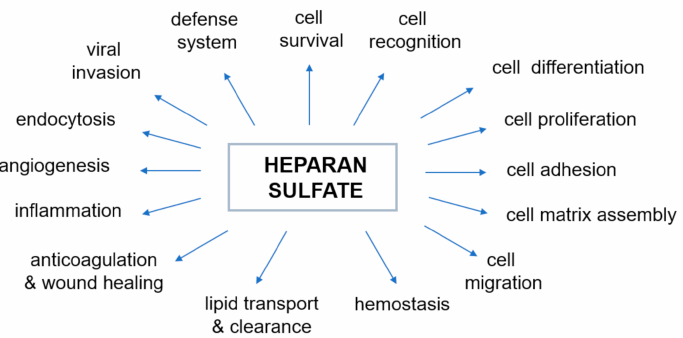
Figure 2. Biological activities modulated by the interaction of heparan sulfate with proteins. The diagram was prepared based on the information included in the following papers: